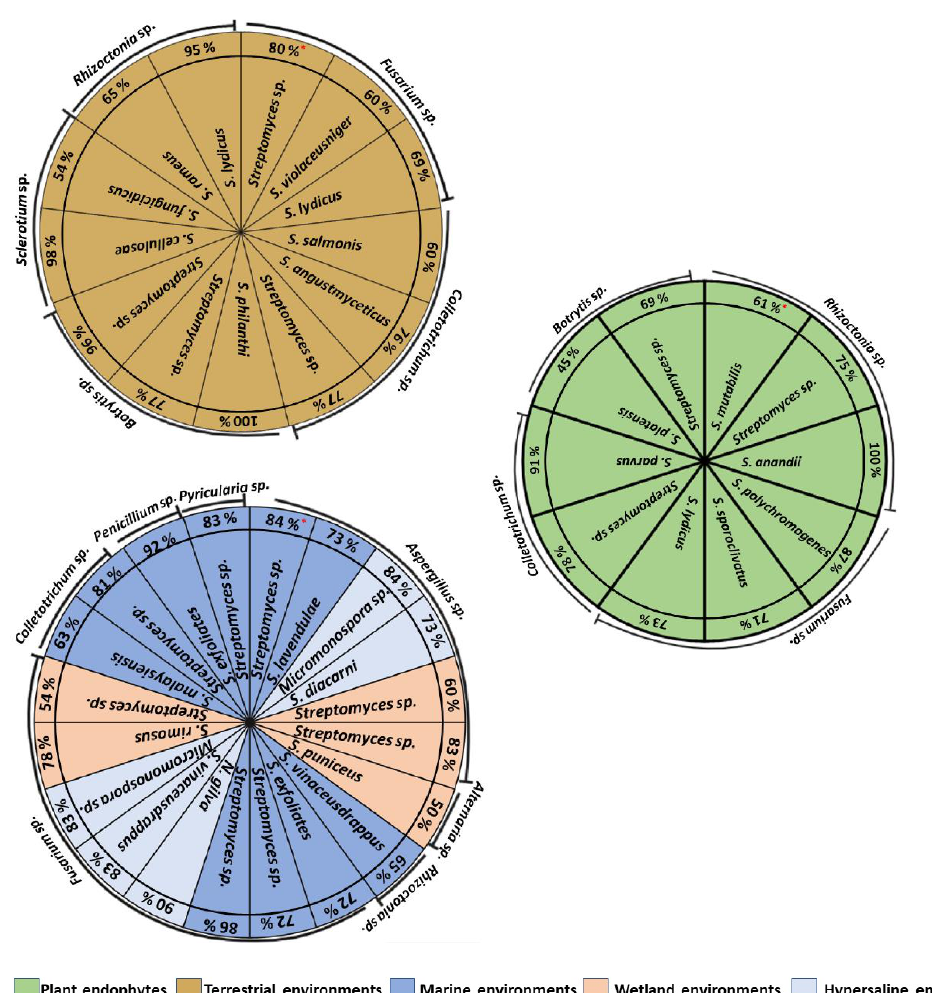
Figure 2. Antifungal activity (% growth inhibition * ) in vitro of actinomycetes isolated from different environments [1,3,4,6,10,19 – 21,53,59,60,64 –